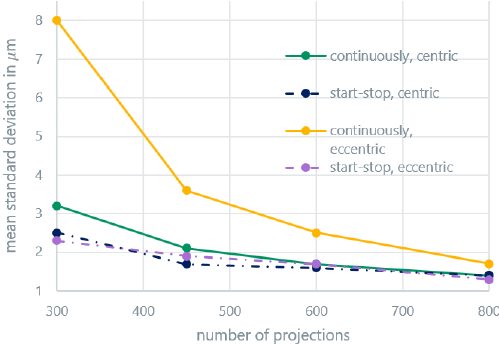
Figure 4. Random measurement error in distance